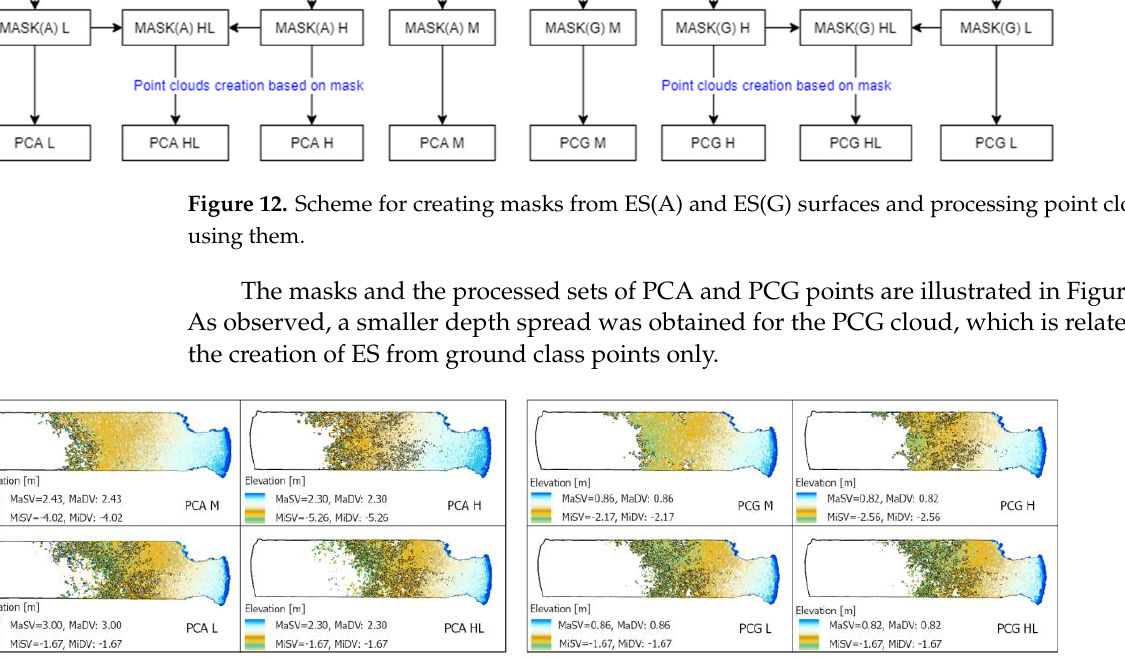
Figure 13. Range of masks and processed point clouds (color scale represents individual 10 elevation classes based on Natural Breaks (Jenks) method).